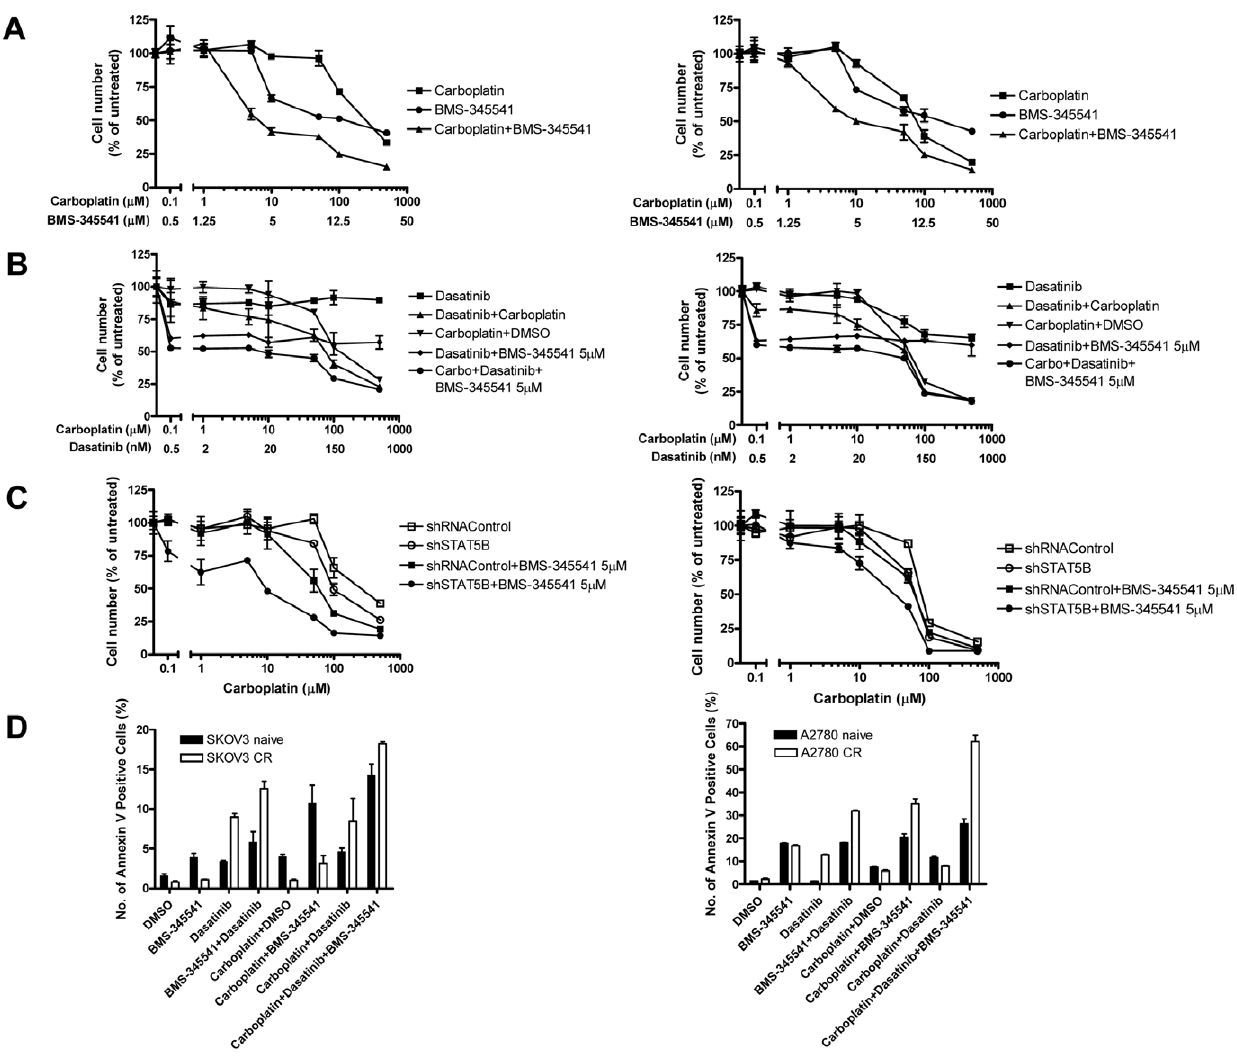
Figure 6. Co-inhibition of RELA and STAT5B pathways by small molecule inhibitors synergistically sensitizes chemoresistant ovarian cancer cells to cytotoxic effect of carboplatin. A) SKOV3-CR (left panel) and A2780-CR cells (right panel) were treated with a series of concentrations of carboplatin and BMS-345541 for 4 days before IC 50 curves were obtained. B) SKOV3-CR (left panel) and A2780-CR cells (right panel) were treated with a series of dasatinib concentrations, or a series of carboplatin concentrations, or 5 m M BMS-345541 in combination with a series of dasatinib concentrations, or a series of concentrations of dasatinib and carboplatin, or 5 m M BMS-345541 in combination with a series of concentrations of dasatinib and carboplatin for 4 days before IC 50 curves were measured. C) SKOV3-CR (left panel) and A2780-CR cells (right panel) were either transfected with STAT5B- or control shRNAs, with or without 5 m M BMS-345541 treatment, and subjected to a series of concentrations of carboplatin for 4 days before IC 50 curves were determined. D) Annexin V assay to measure apoptosis of chemoresistant cells and their naı¨ve counterparts after treatment with carboplatin (6 m g/ml) and/or BMS-345541 (5 m M) and/or dasatinib (100 nM) for 48 hours. Annexin V positive cells were quantified using flow cytometry. Left panel: SKOV3-CR; right panel: